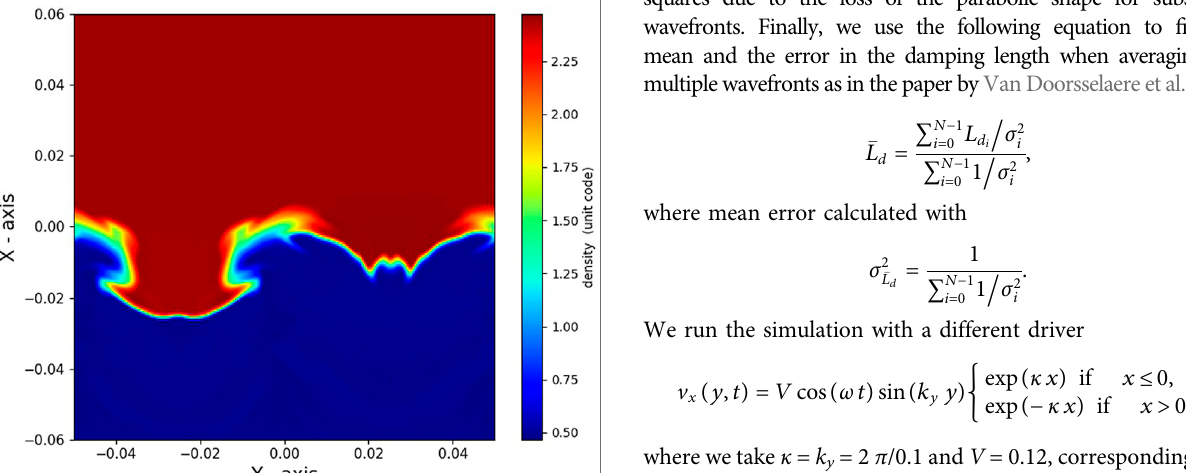
comparison, blue dots show the average damping time for the fi rst fi ve wavefronts. The error bars were calculated starting from the Fourier transform by taking the standard deviation σ , where we computed it using numpy std routine. We apply uncertainties on the poly fi t function, and the estimated damping length was taken from the fi tted exponential function, including the uncertainties from the covariance matrix. The errors on the blue dots are bigger than the red